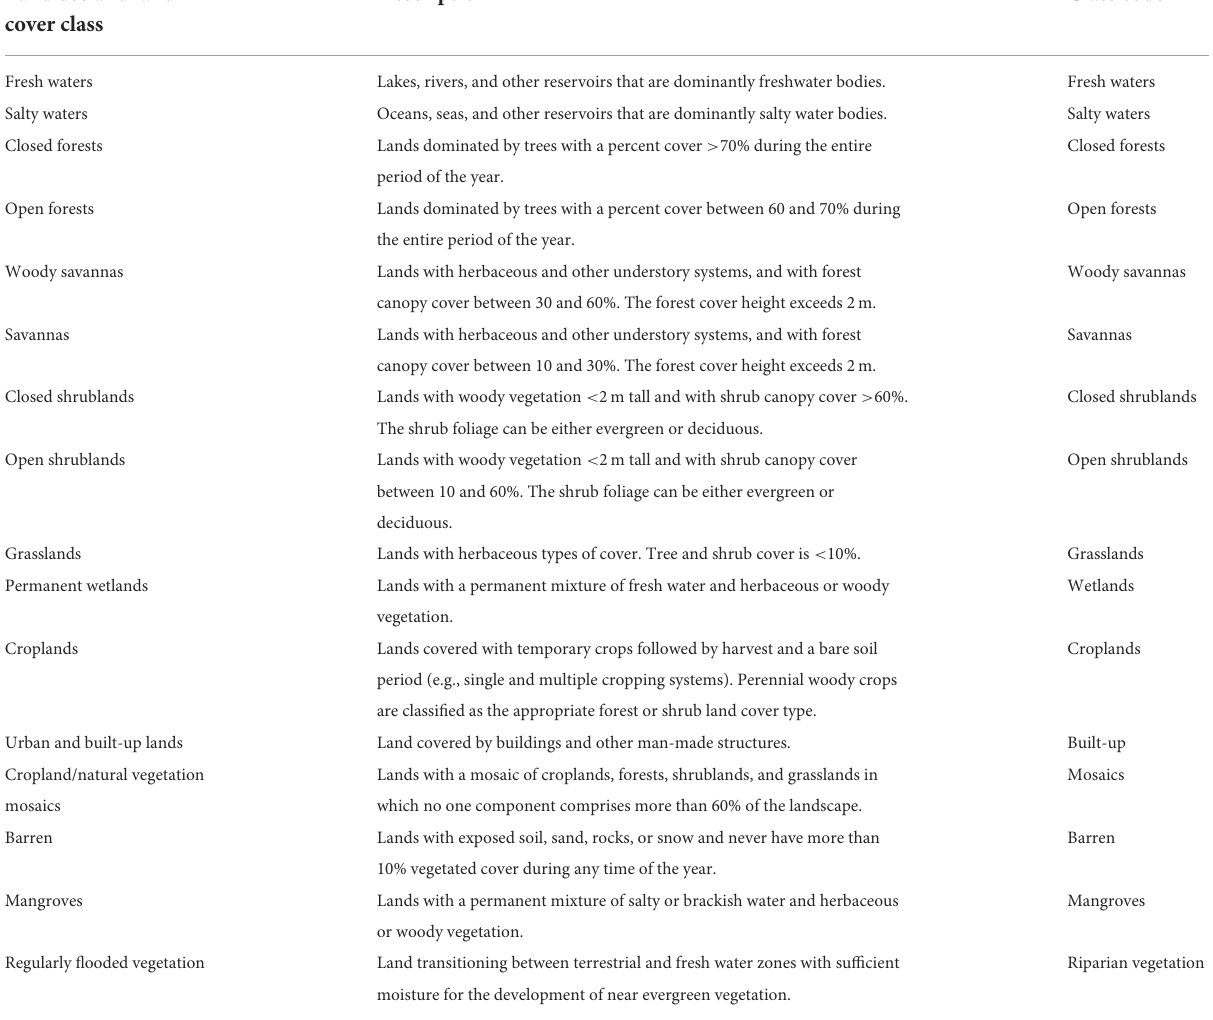
TABLE 1 Categories of land use and land cover used for image classification in The Gambia. Land use and